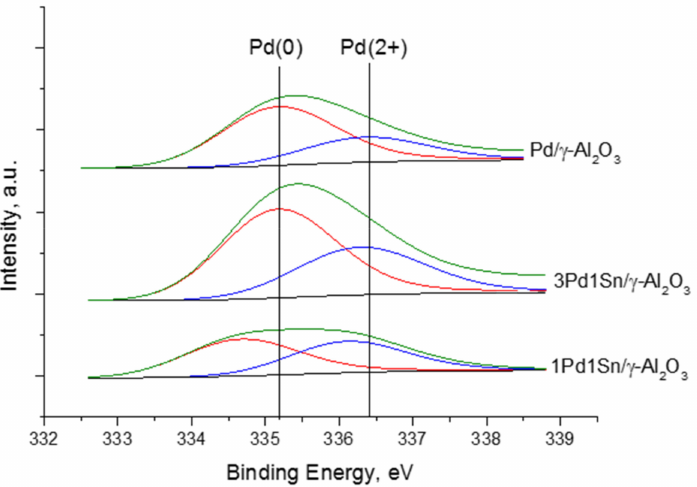
Figure 4. Pd3d 5/2 core-level XPS spectra for Pd/ γ -Al 2 O 3 , 3Pd1Sn/ γ -Al 2 O 3 and 1Pd1Sn/ γ -Al 2 O 3 . Deconvolution with two contributions Pd(0) and Pd(2+) is